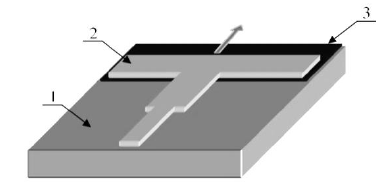
Fig. 3. The experimental scheme.